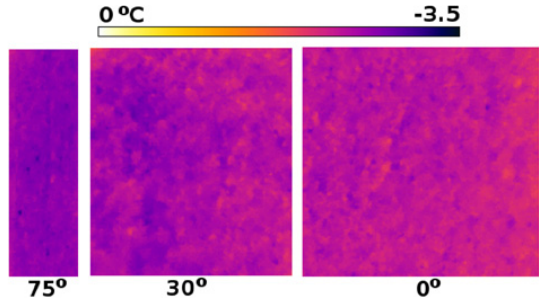
Fig. 3. Thermographs of the same 20 × 20cm area at a 75, 30, and 0 degree photographic